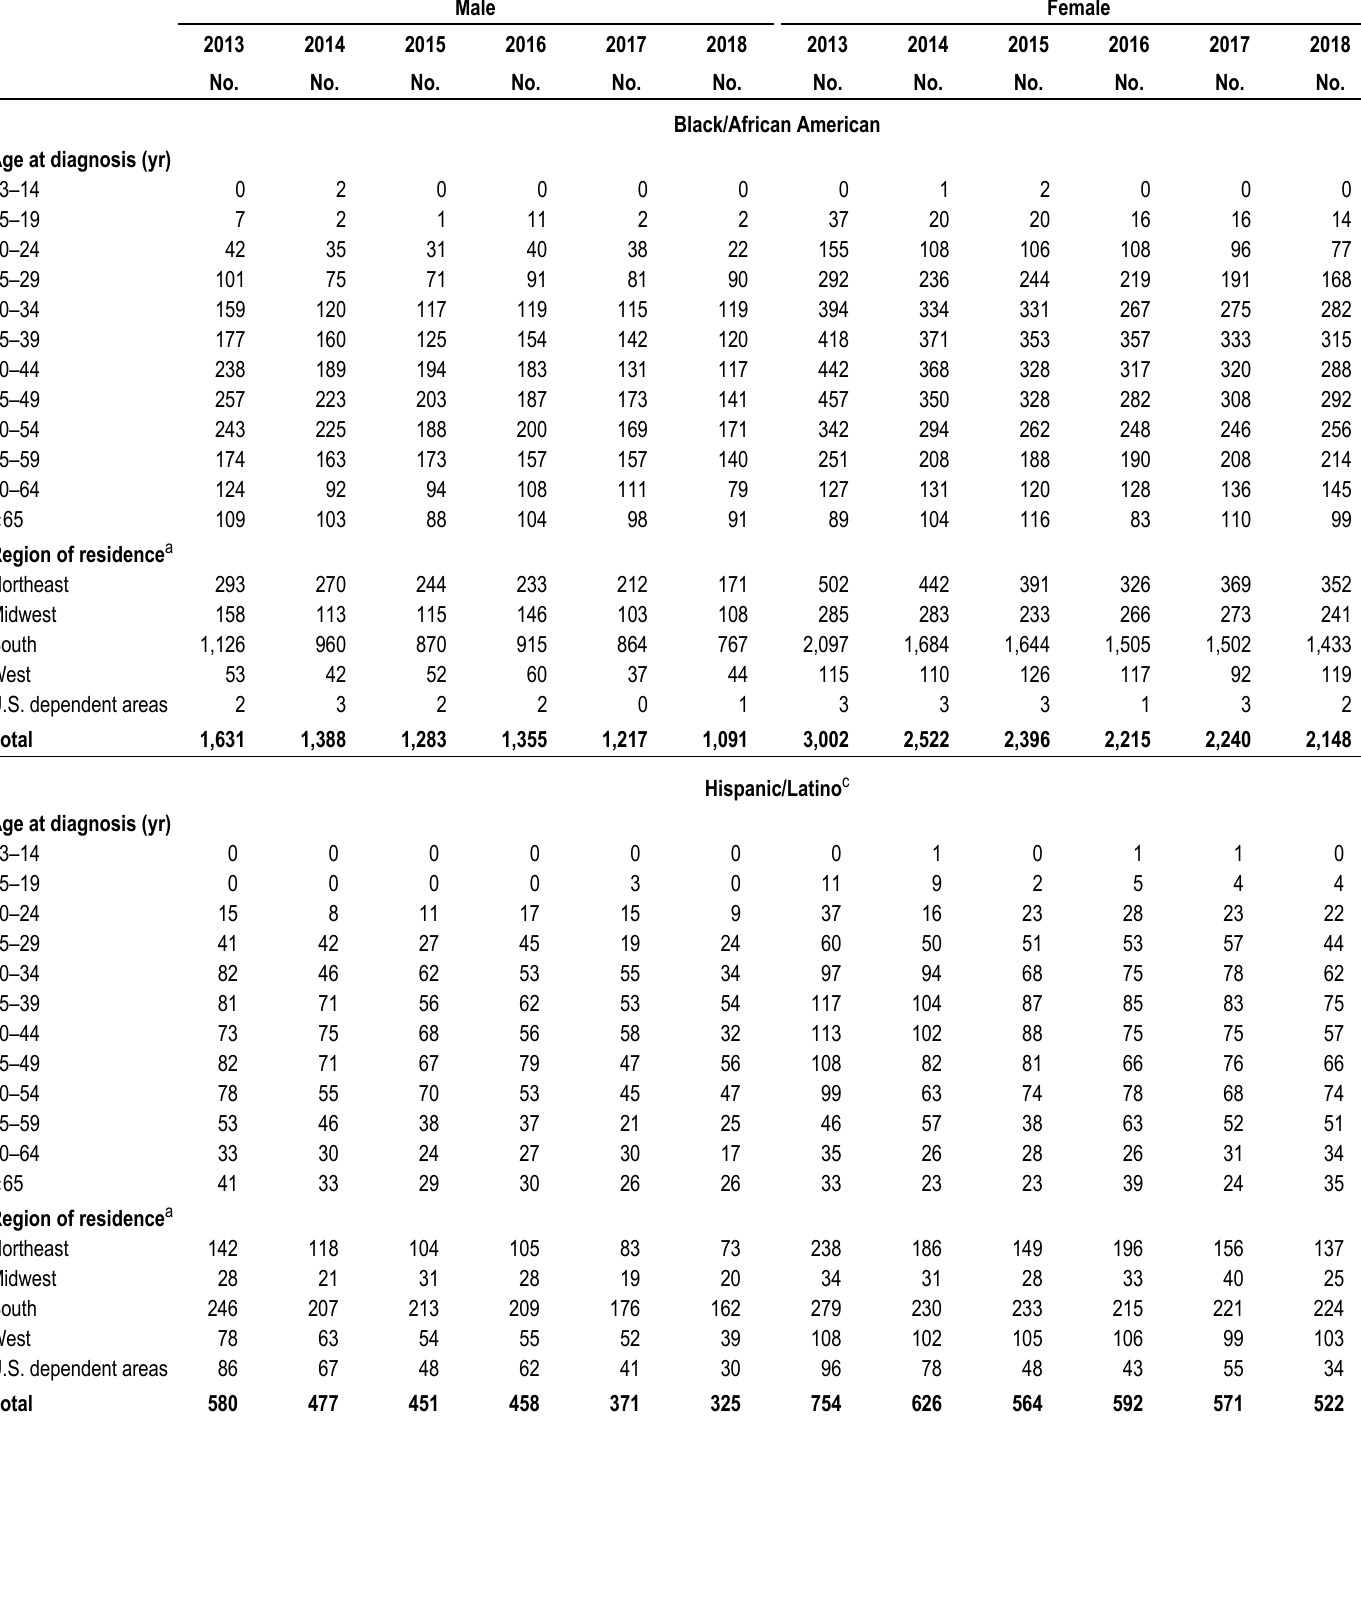
Table 12b. Stage 3 (AIDS) attributed to heterosexual contact, by selected characteristics, 2013–2018—United States and 6 dependent areas (cont) Male